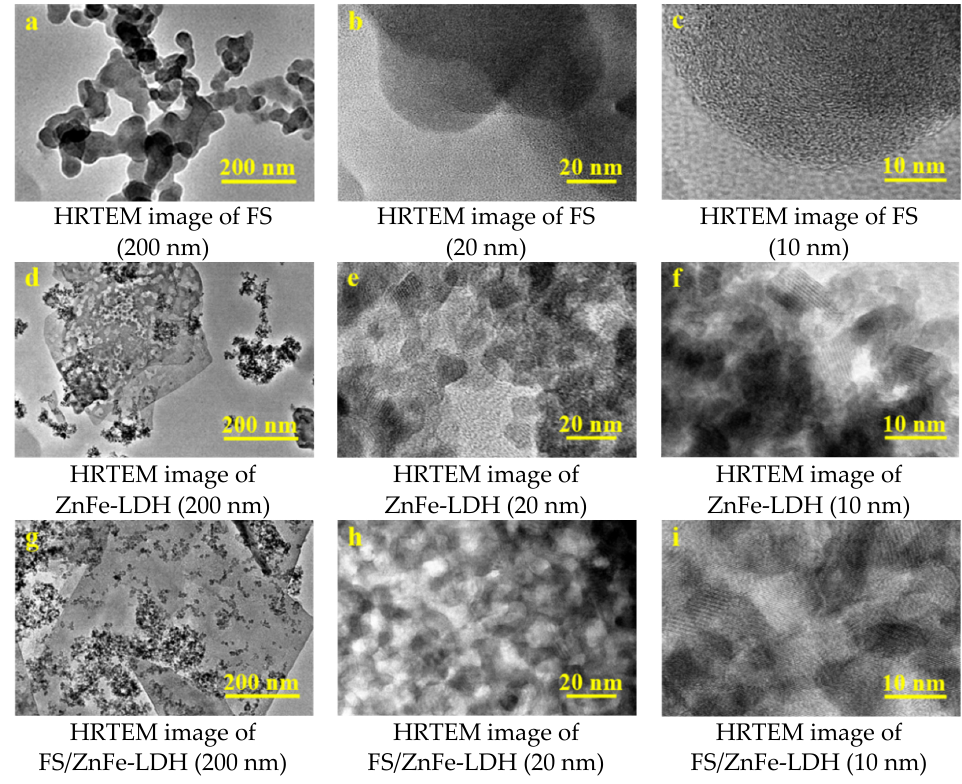
Figure 5. High Resolution Transmission Electron Microscope ( HRTEM) diagram of ZnFe-LDH, FS/ZnFe-LDH, and FS.